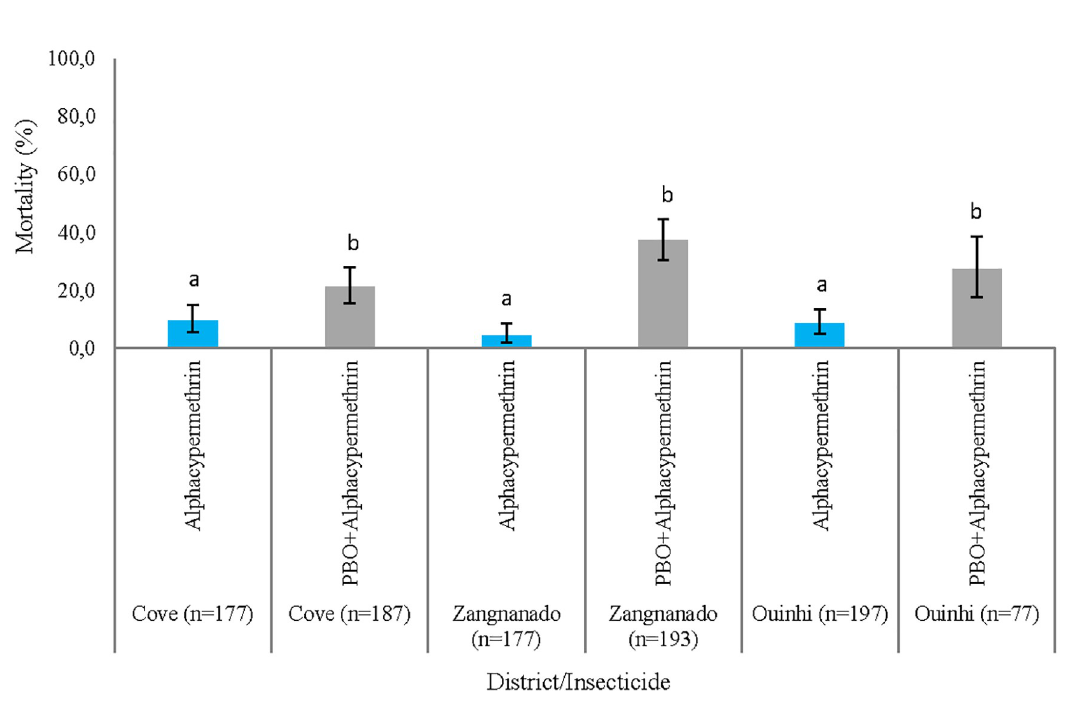
Fig 5. 24 hours Mortality of An . gambiae s.l. to alpha-cypermethrin and PBO+alpha-cypermethrin in Cove, Ouinhi and Zangnanado, the error bars indicate the confidence intervals.